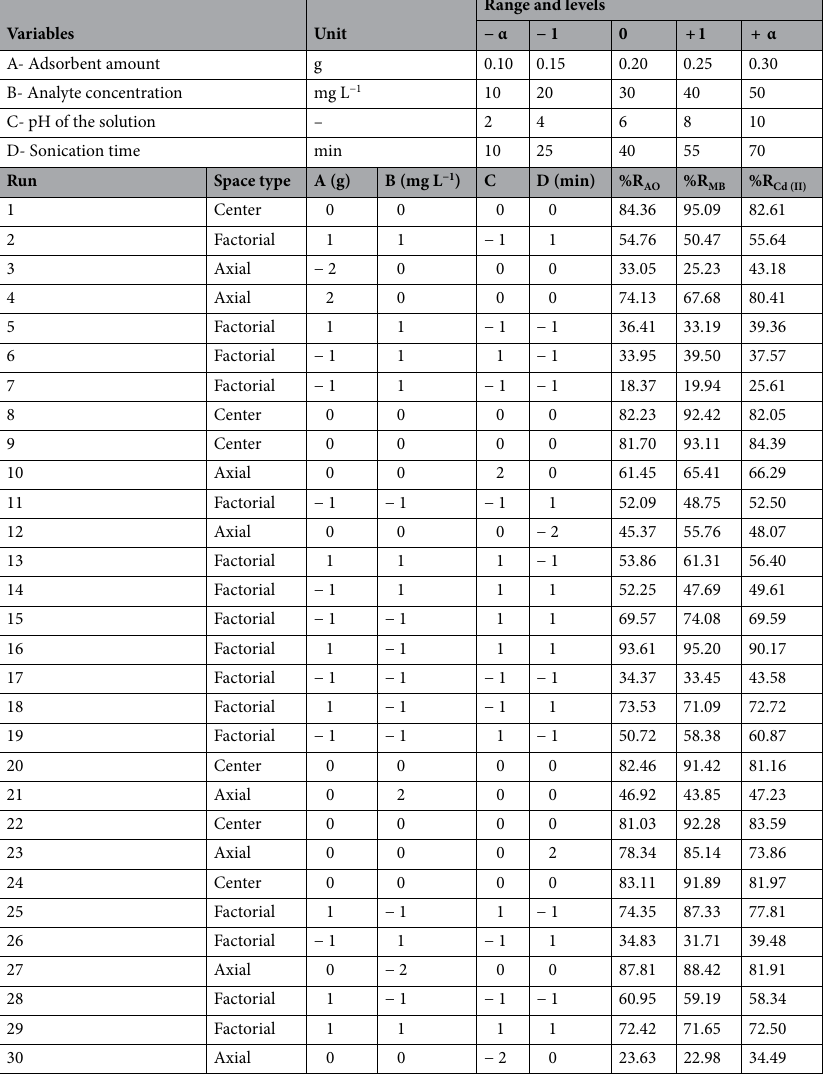
Table 1. The design of